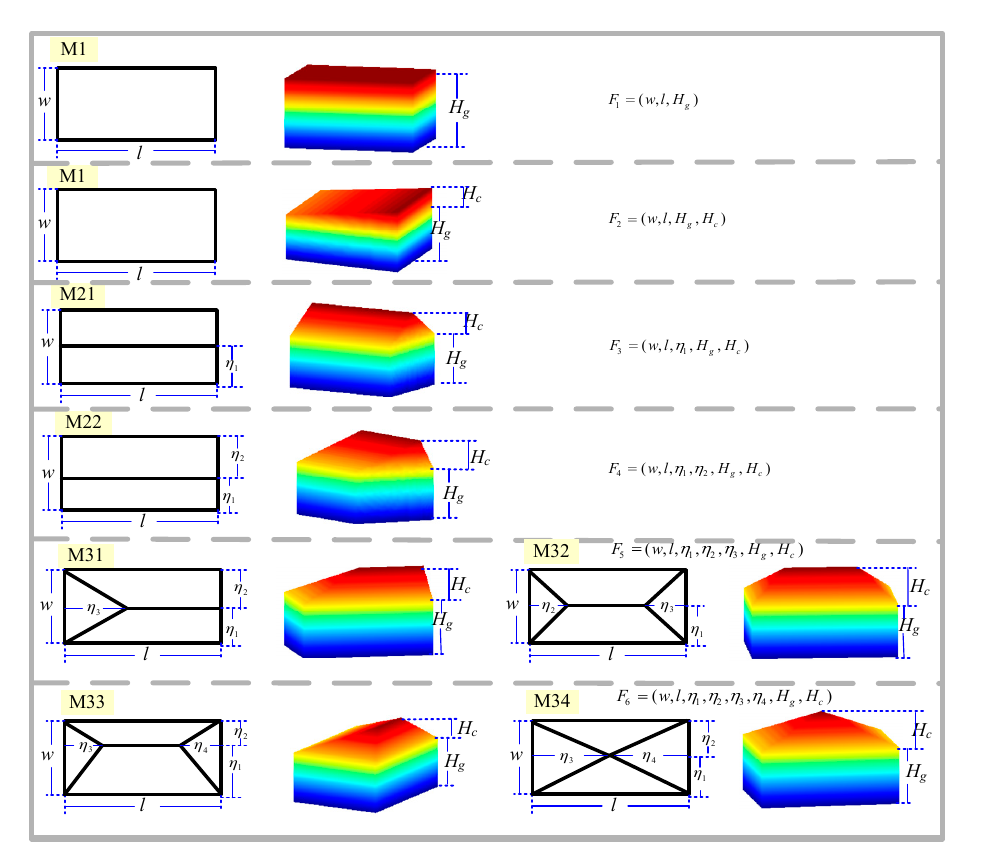
Figure 2. Typical basic-unit-models.